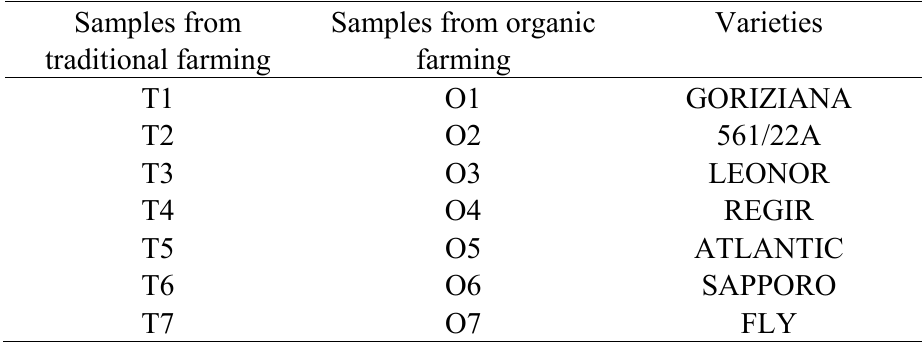
Table 4. Soybean varieties